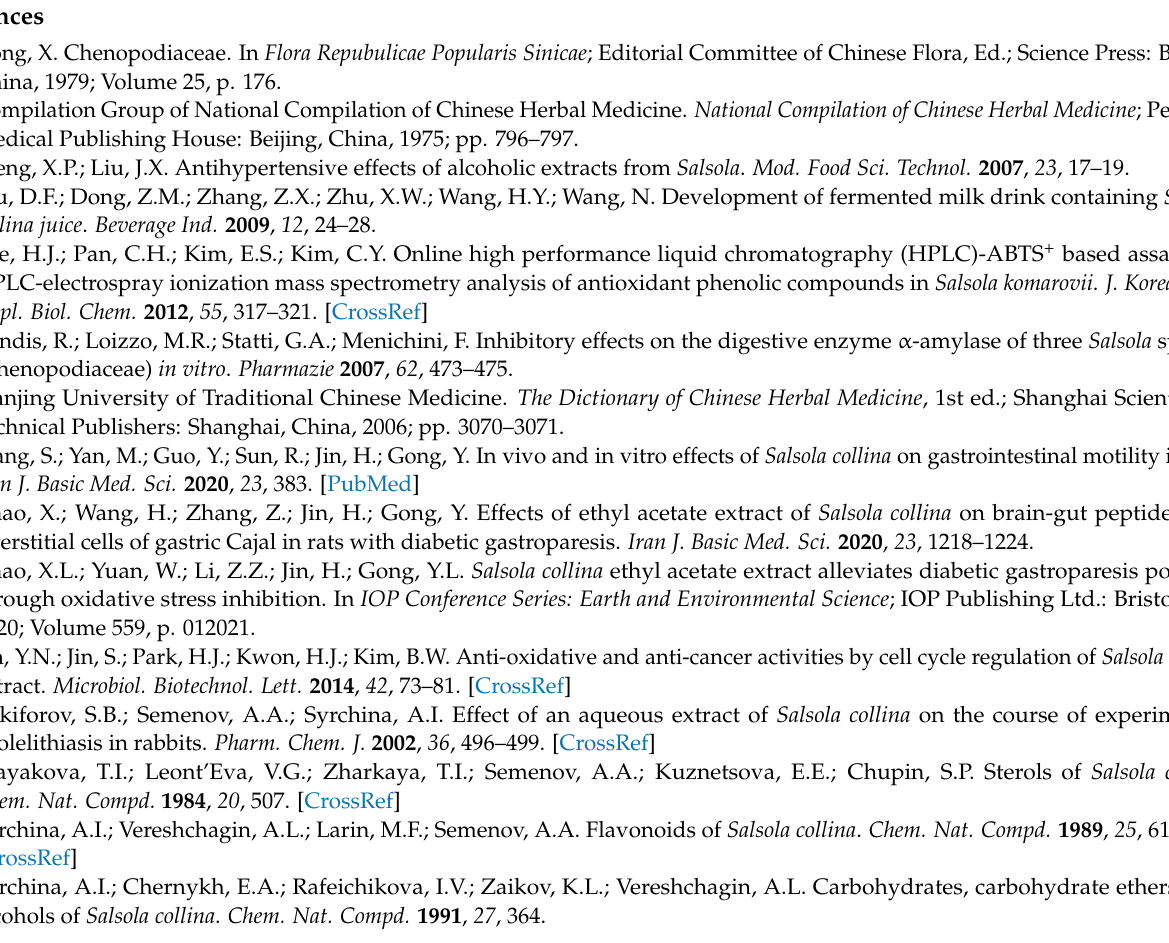
Supplementary Materials: The supplementary materials are available online. Figure S1: Total ion chromatogram of the L-Sc and R-Sc under negative ion mode (A) and positive ion mode (B). Figure S2: OPLS-DA model validation diagram. Figure S3: KEGG pathway classification of the differential metabolites in the L-Sc vs. R-Sc dataset. Table S1: List and characteristics of the metabolites identified and quantified in S. collina. Table S2: List of differentially accumulated metabolites in the L-Sc vs. R-Sc dataset. Table S3: Statistics of differentially accumulated metabolites between L-Sc and R-Sc. Table S4: List of KEGG pathway in the L-Sc vs. R-Sc